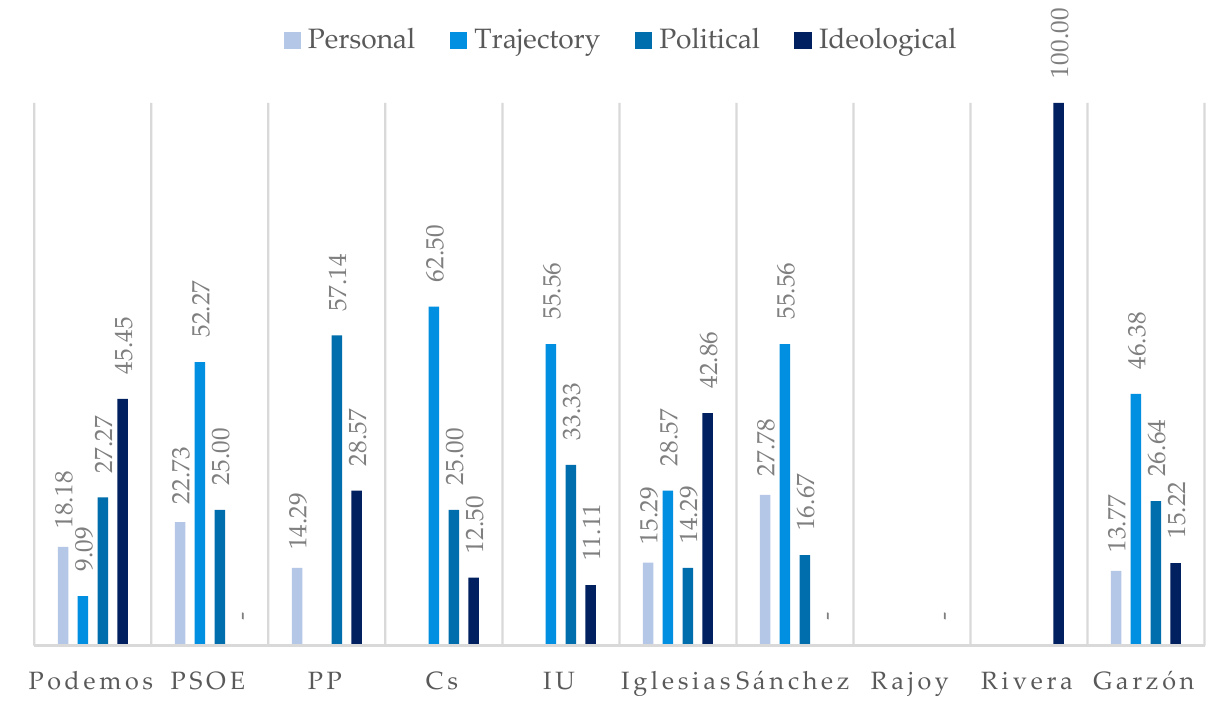
Figure 2. Type of Criticism Used by Political Actors on Facebook (%).